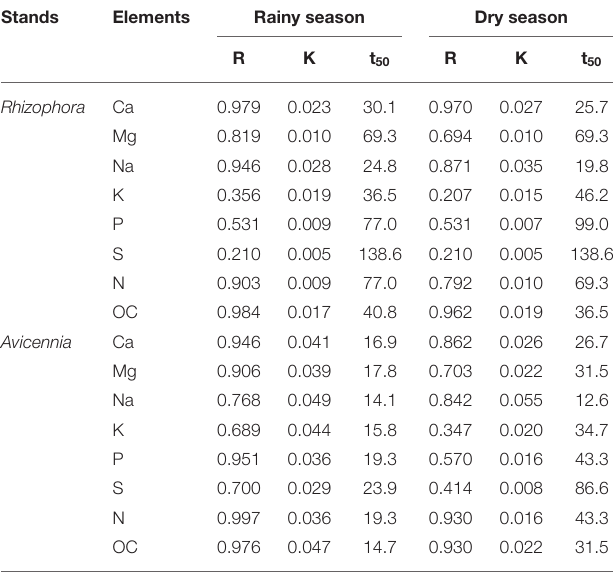
TABLE 2 | Simple negative exponential regression equations (X = ae − kt ), % of litter mass remaining in the litterbags (X) with time (t) during decomposition of leaf litter in the studied Rhizophora and Avicennia stands. Stands Elements Rainy season Dry